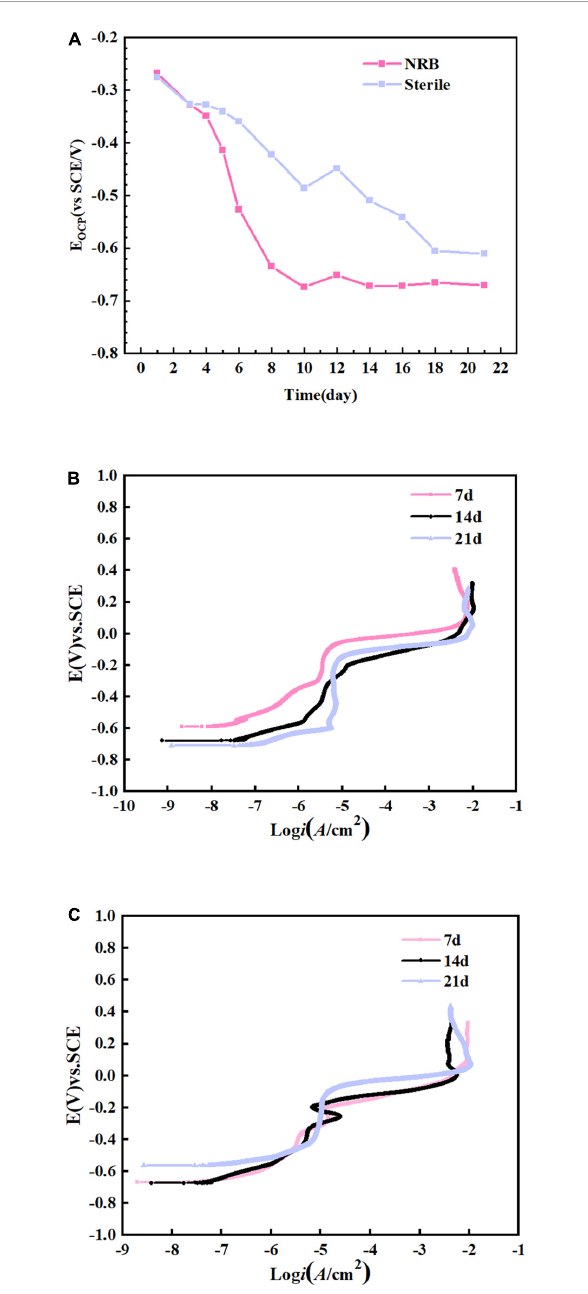
FIGURE9 B30 copper–nickel alloy specimens in abiotic medium and P. aeruginosa : (A) open-circuit potentia (OCP) and (B , C) anodic polarization curves.